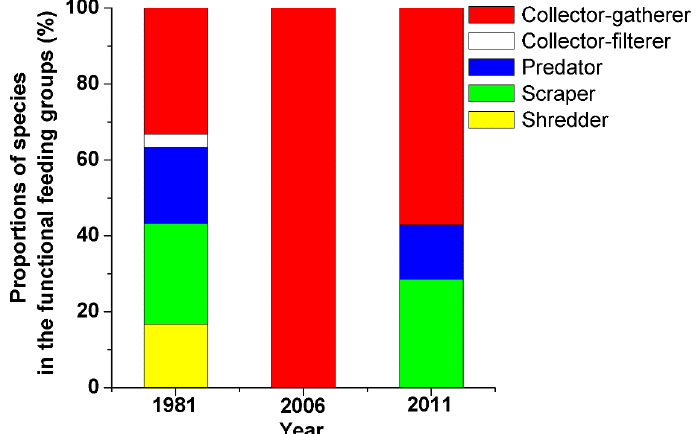
Figure 4. Changes in the composition of the functional feeding groups. The 1981 and 2006 data were collected from the literature [17,18]. The 2011 data were obtained from the